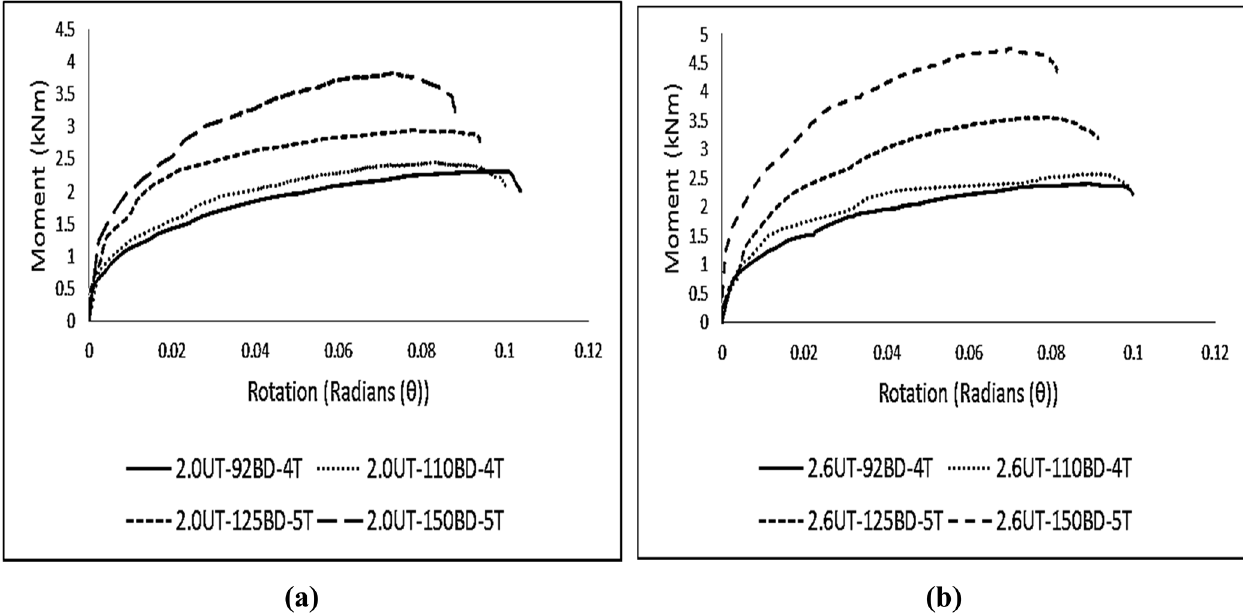
Fig 5. Average M- θ graphs for each set of specimens. M- θ graphs for specimens with column A, (b) M- θ graphs for specimens with column B. Contrary to an idealized graph of connections, these curves indicate non-linear behavior from the starting point. The major reasons for this overall non-linear behavior is due to the relative slippage between the column and the beam end connector, yielding of the tabs, or some points on the end-connector or the column perforation walls due to localized stress concentration, and geometrical non-linearity. The average results of experimental testing are given in Table